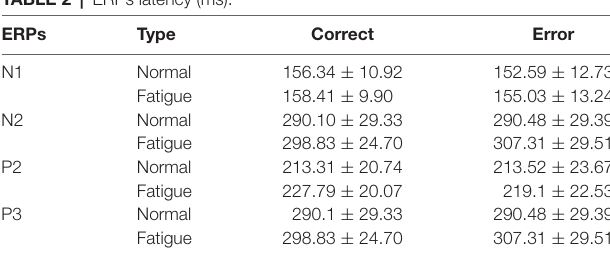
TABLE 2 | ERPs latency